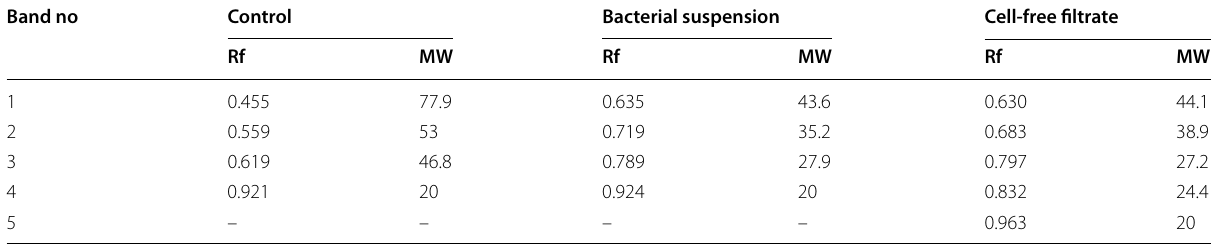
Table 2 Relative frequency values and molecular weights of SDS protein bands detected in the whole-body homogenates of Locusta migratoria migratorioides 5th instar nymph treated with LC of bacterial suspension and its Cell-free filtrate 50 Band no Control Bacterial